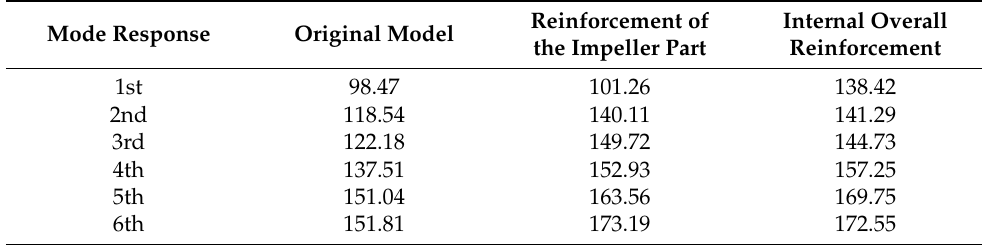
Table 7. Natural frequency (Hz) of the water tank.